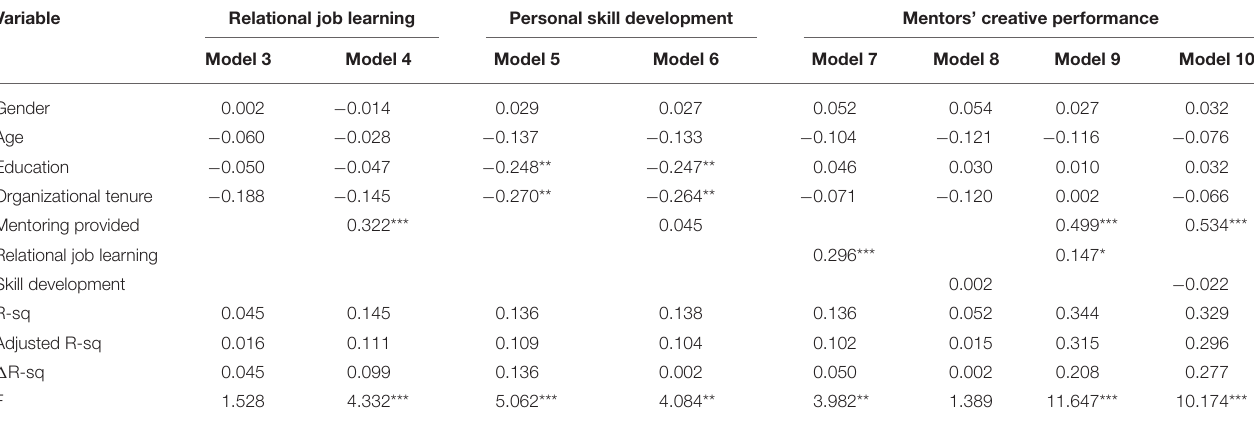
TABLE 4 | Mediation regression results.